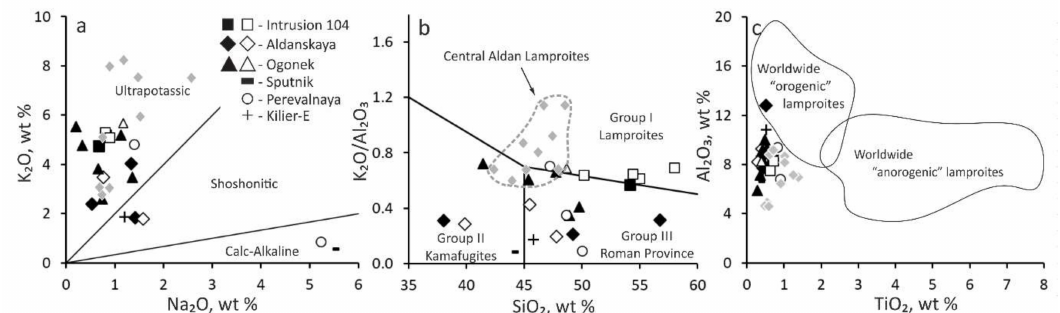
Figure 8. K 2 O vs. Na 2 O diagram [85] ( a ); bold line dividing alkaline and subalkaline rock series based on [86]; major element variation diagrams of K 2 O / Al 2 O 3 vs. SiO 2 for ultrapotassic rocks subdivided into three main groups: group I lamproites, group II kamafugites and group III Roman Province, based on [85] ( b ); Field for Central Aldan lamproites plotted according to [11]. Al 2 O 3 vs. TiO 2 diagram for the Chompolo rocks ( c ); filled black symbols are data from this work and empty symbols are data from [25]; data for worldwide orogenic and anorogenic lamproites (data from [87] and references there in) are reported for comparison.